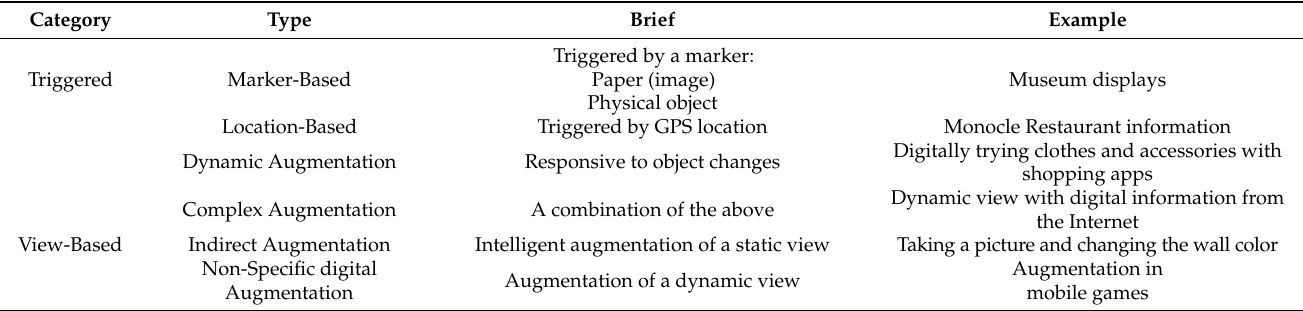
Table 2. Classification of augmented reality types